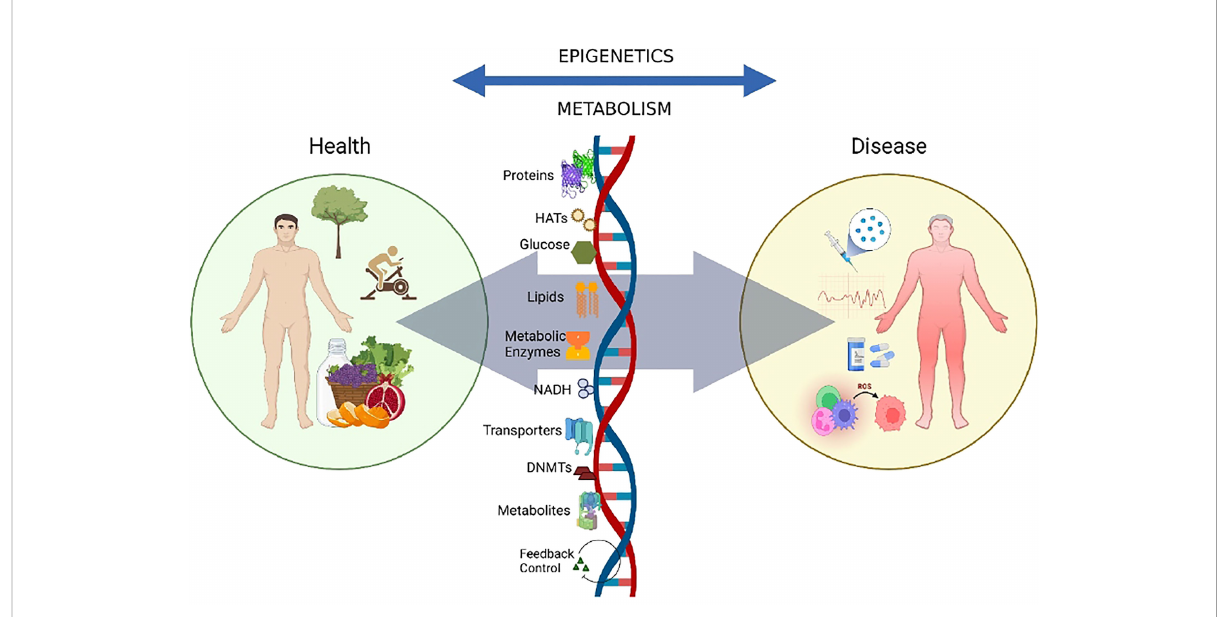
FIGURE 1 Crosstalk between epigenetics and metabolism.The crosstalk between epigenetics and metabolism is implicated in a variety of contexts related to disease progression. The availability of modi fi ers like metabolites, co-factors, chromatin-modifying enzymes, and other environmental factors like nutrition, exercise, and the gut microbiome, modulate the dynamics of the genome, thus contributing towards metabolic and epigenetic control and disease